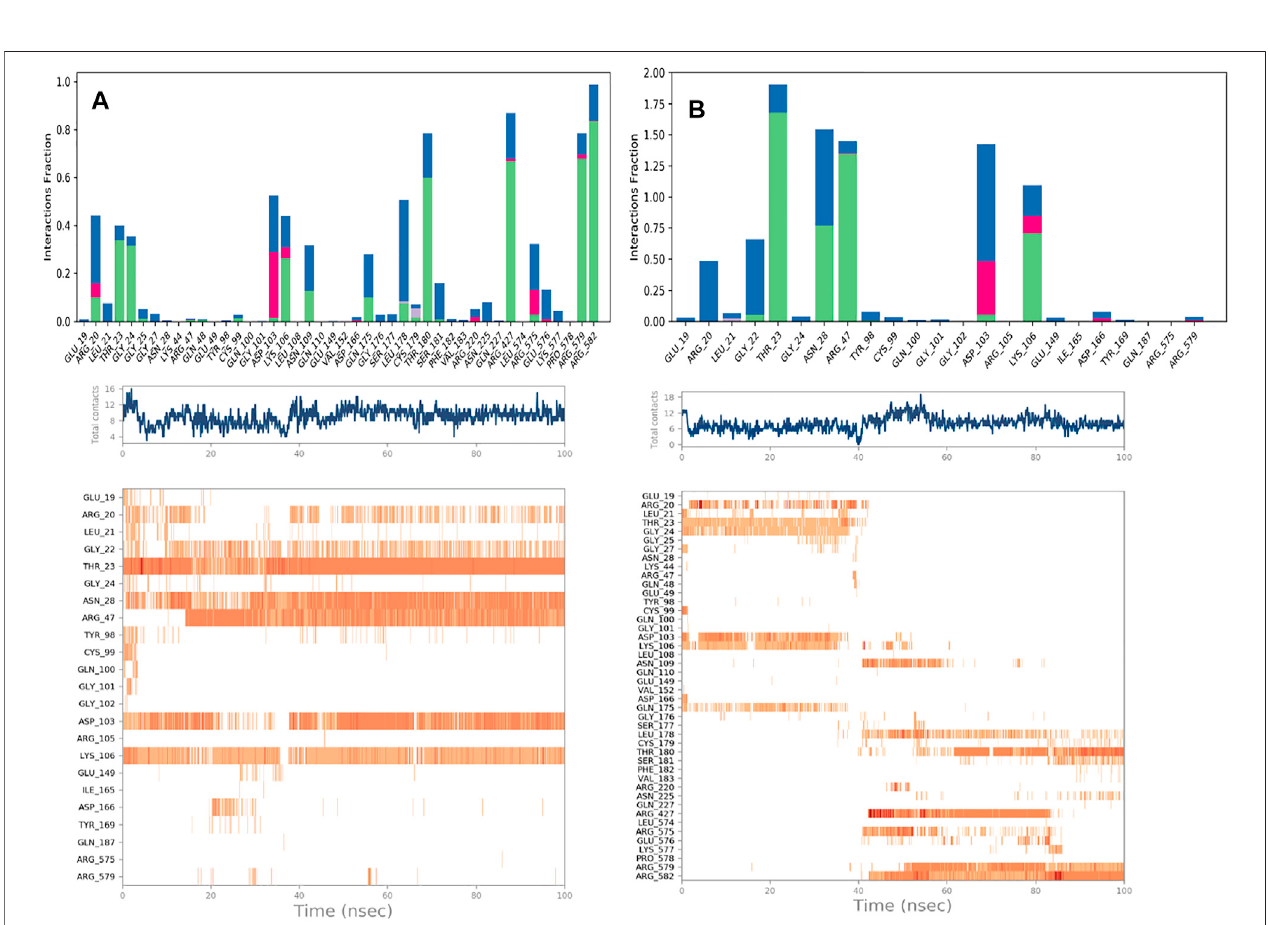
FIGURE 9 | Protein-Ligand contacts: Indicaxantin in Chain A (A) Indicaxanthin in Chain B (B) . Legenda is the same as Figure 8 .